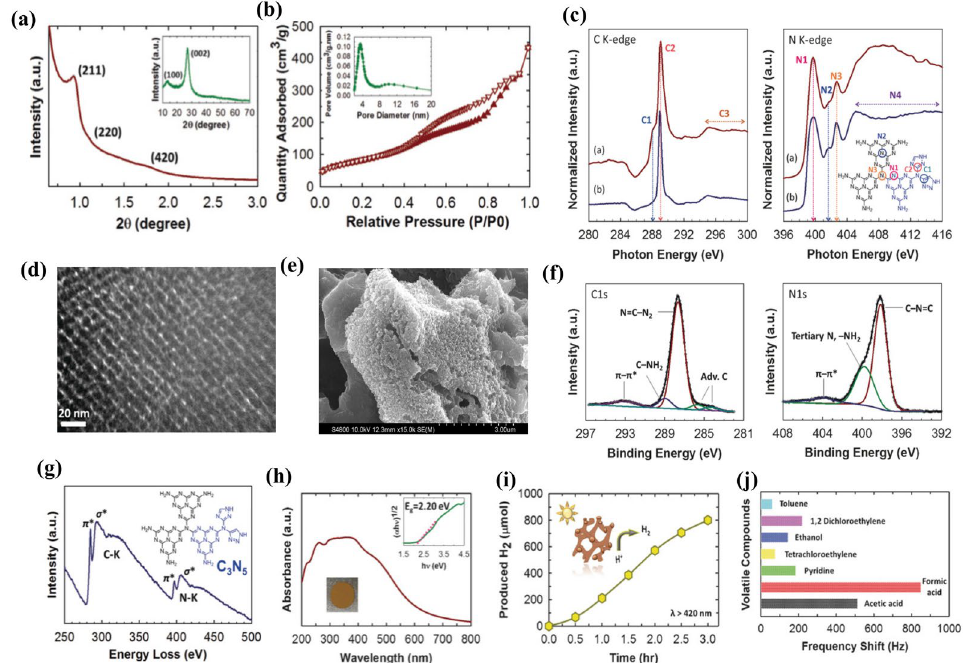
Figure 4. Structural characterization and applications of MCN-8: ( a ) Low-angle powder XRD pattern (inset: wide-angle powder XRD pattern); ( b ) N 2 adsorption-desorption isotherm; ( c ) Carbon K-edge and nitrogen K–edge NEXAFS spectra (red line for MCN-8, blue line for g-C 3 N 4 , and the inset for the proposed molecular structure); ( d ) TEM image; ( e ) FE-SEM images; ( f ) High-resolution XPS spectra: C1s and N1s; ( g ) EEL spectrum; ( h ) UV–Vis absorption spectrum; ( i ) H 2 evolution amount in visible light; ( j ) Gas adsorption detected by the QCM sensor. Adapted with permission from [18]. Copyright Wiley-VCH Verlag GmbH and Co. KGaA, Weinheim,